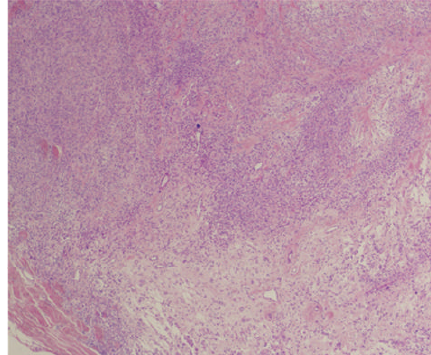
Figure 2: Admixture of hypocellular and hypercellular areas (HE, ×